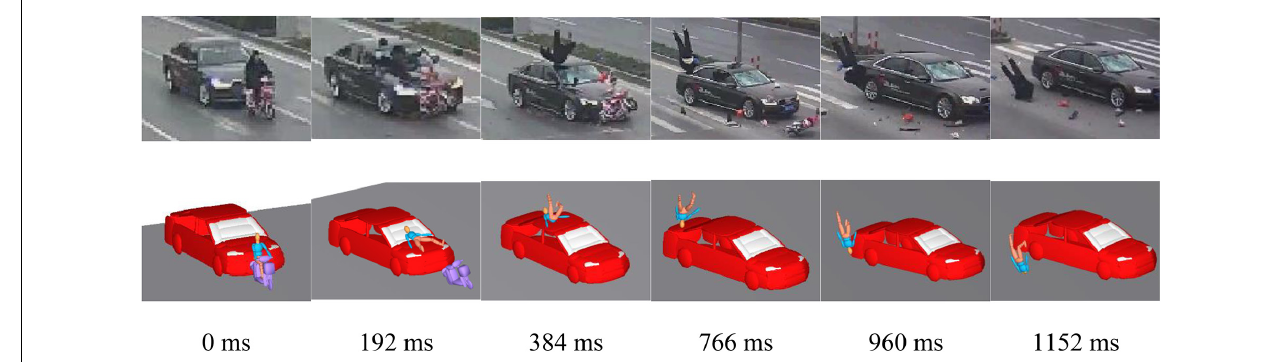
FIGURE 2 | Comparison between the elderly reconstruction kinematics and the video records in case 9.